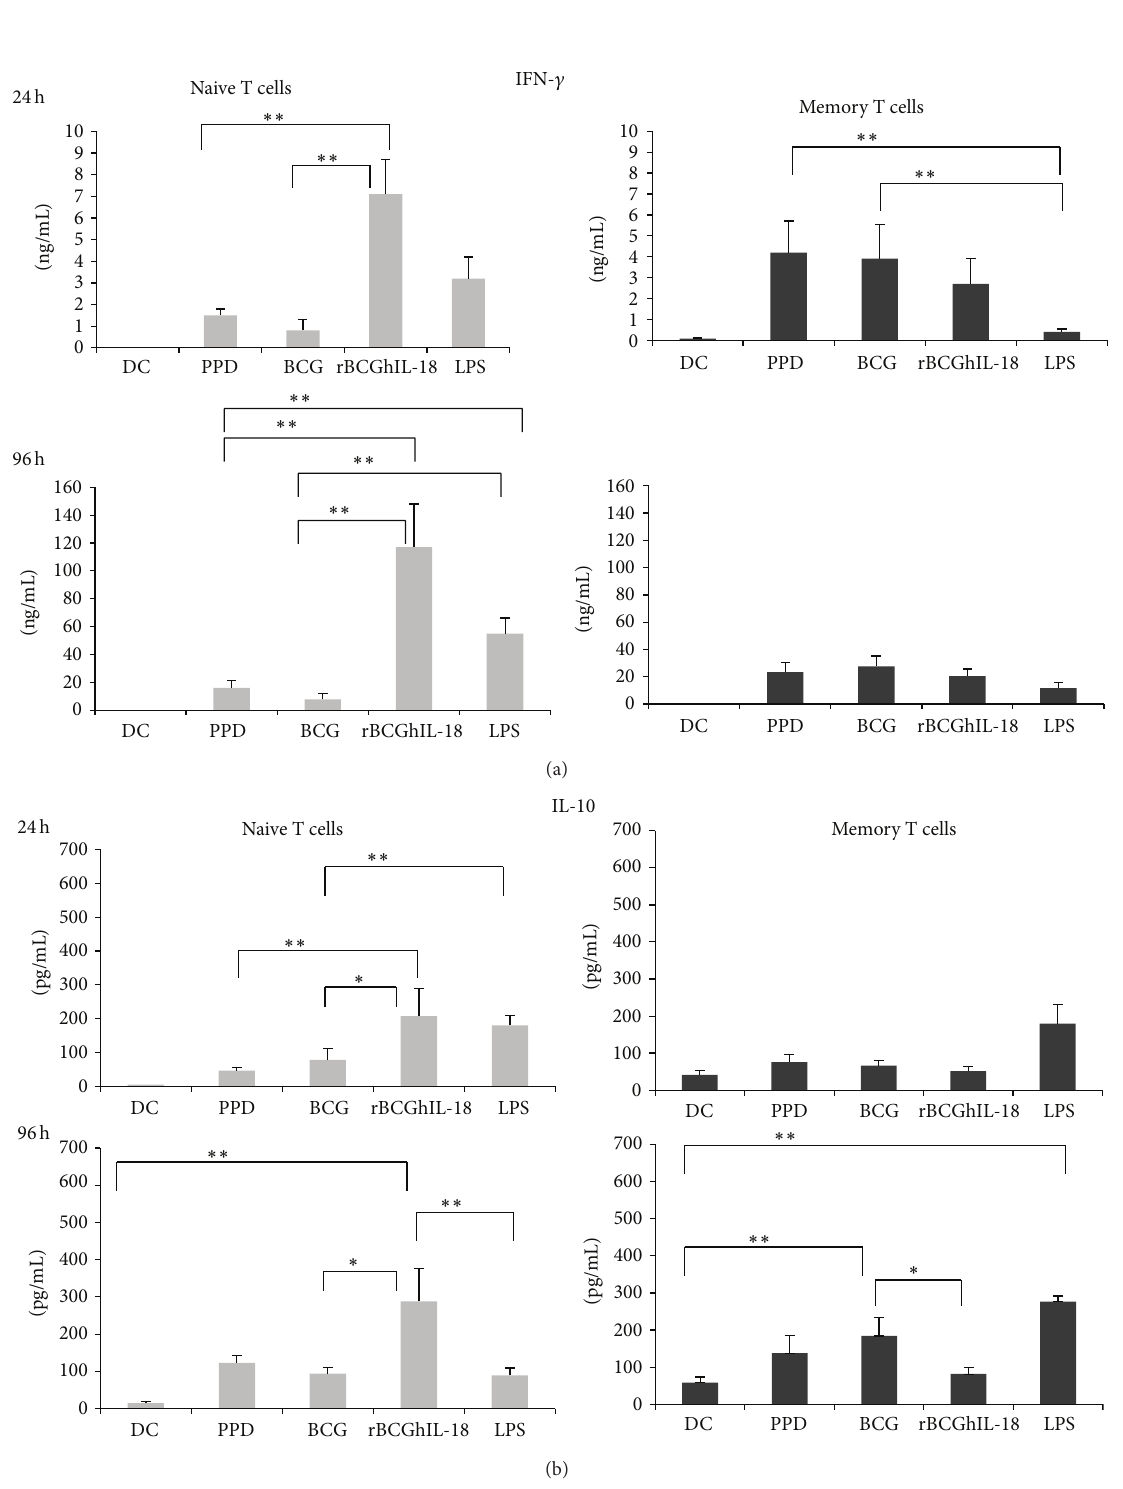
Figure 7: Secretion of IFN- 𝛾 (a) and IL-10 (b) by human naive (grey bars) and memory (black bars) T cells following 24h and 96 h coculture with PPD- (10 𝜇 g/mL), BCG- (1: 1), rBCGIL-18- (1:1), or LPS- (1 𝜇 g/mL) pulsed autologous MoDCs (ratio MoDCs/T cells, 1 :10). The cytokine levels in the cocultures were measured by ELISA. Data shown are the mean ± SEM of 20 independent donors. Statistical analyses were performed using the Kruskal-Wallis test and Mann-Whitney 𝑈 test. ∗ 𝑃 < 0.05 ; ∗∗ 𝑃 < 0.01